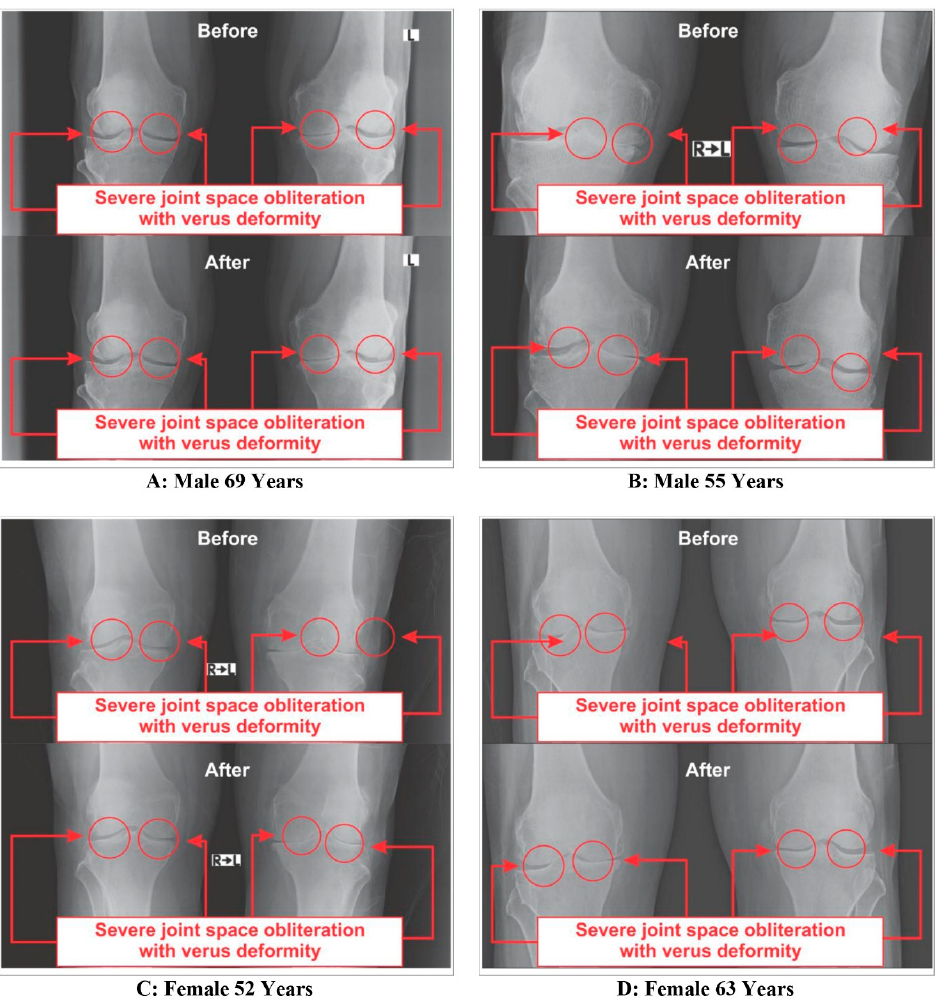
Figure 12. Radiological images of knee joints (two-female and two-male) showing before and after without supplement. Table 4. Kellgren-Lawrence (KL) Grading Scale for Knee-osteoarthritis of experimental and control